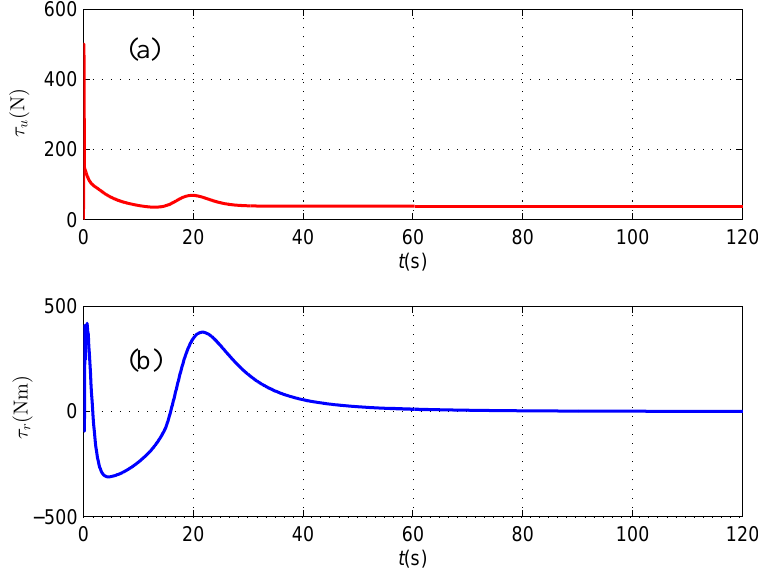
Figure 13. ( a ) Surge control force τ u ; and ( b ) Yaw control moment τ r